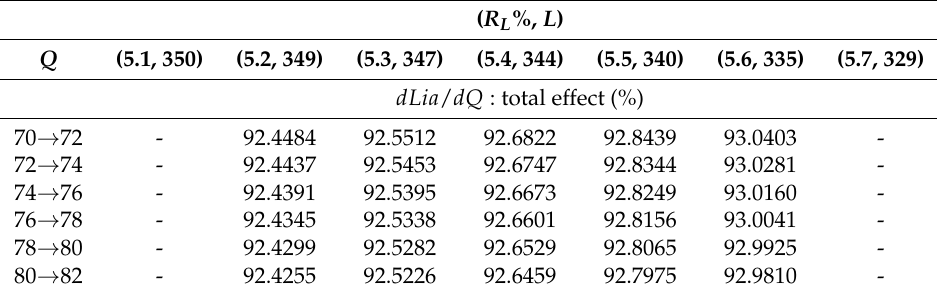
Table 6. Responsiveness of the bank’s liabilities to ELs 1 .